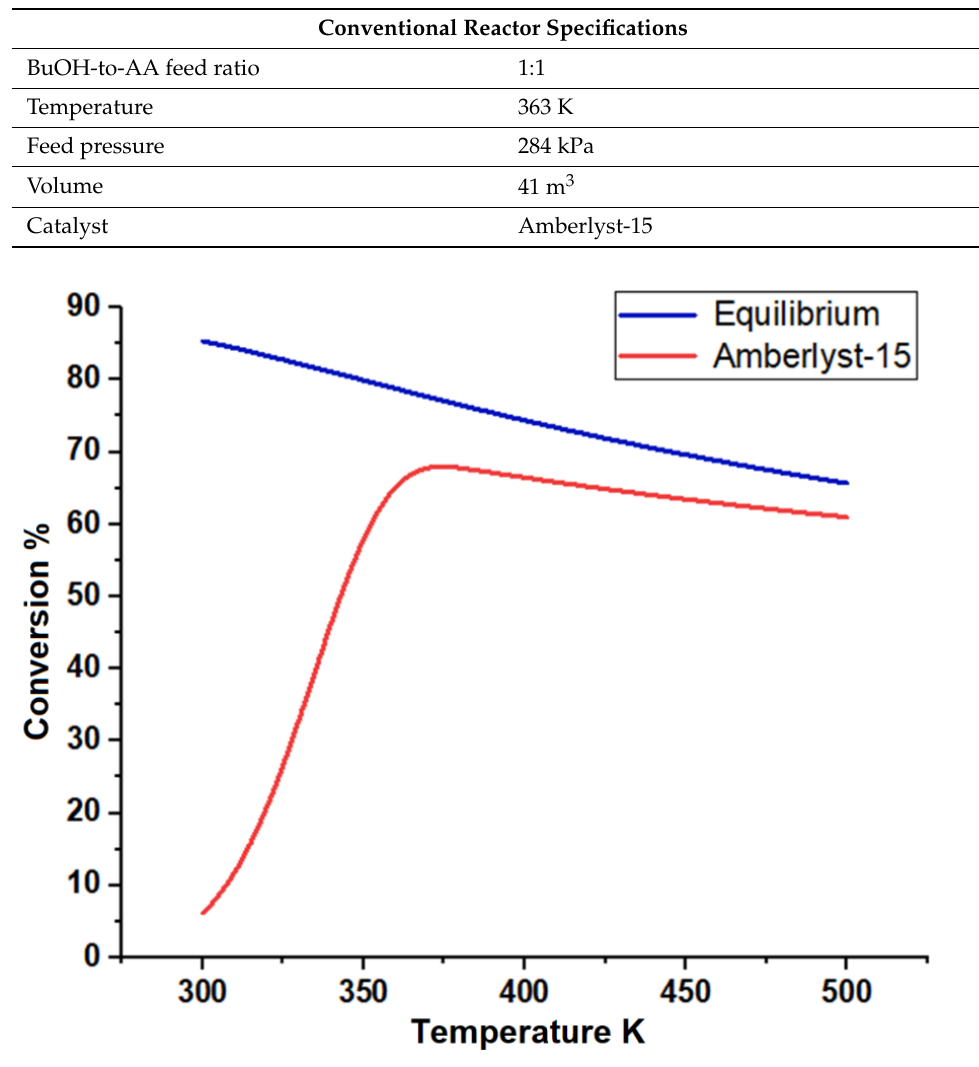
Figure 13. n -butanol conversion as a function of temperature for the esterification process.